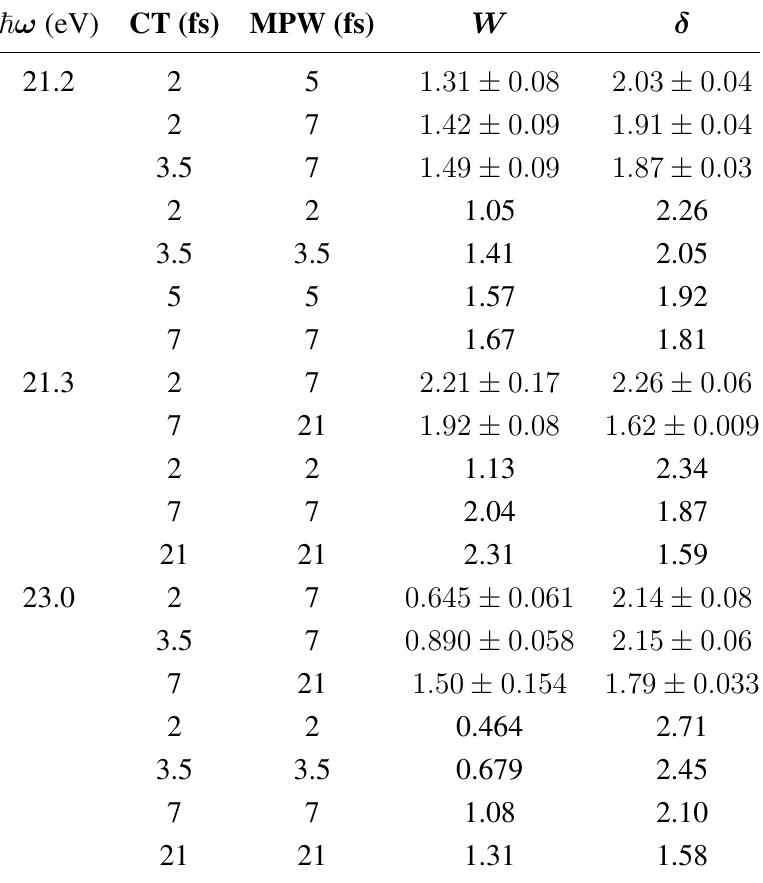
Table 1. W and δ calculated for chaotic pulses generated by the partial-coherence method for several pairs of coherence time (CT) and mean pulse width (MPW). The target atom is helium. The average values and standard deviation errors of W and δ by typically 48 runs are listed. The rows with the same CT and MPW values are for fully coherent Gaussian